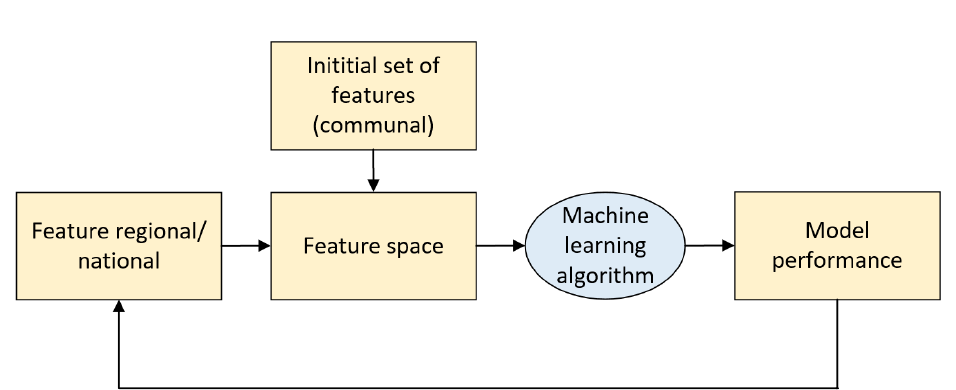
Figure 4. Walk forward validation scheme using an expanding window.